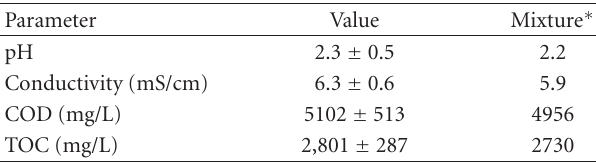
Table 1: Wastewater characterization ( n =